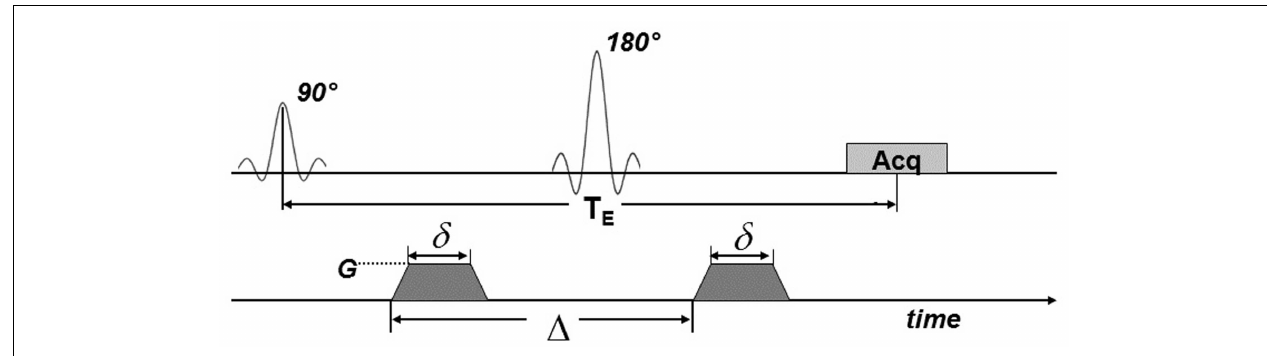
FIGURE 2 | MRI pulse sequence for diffusion weighting. Diffusion gradients (dark shading) were applied on both sides of the 180˚ pulse. Here, T E is the echo time; Acq indicates the signal acquisition block. G is the amplitude of the diffusion gradients, δ is their duration and ∆ is the delay time between them.